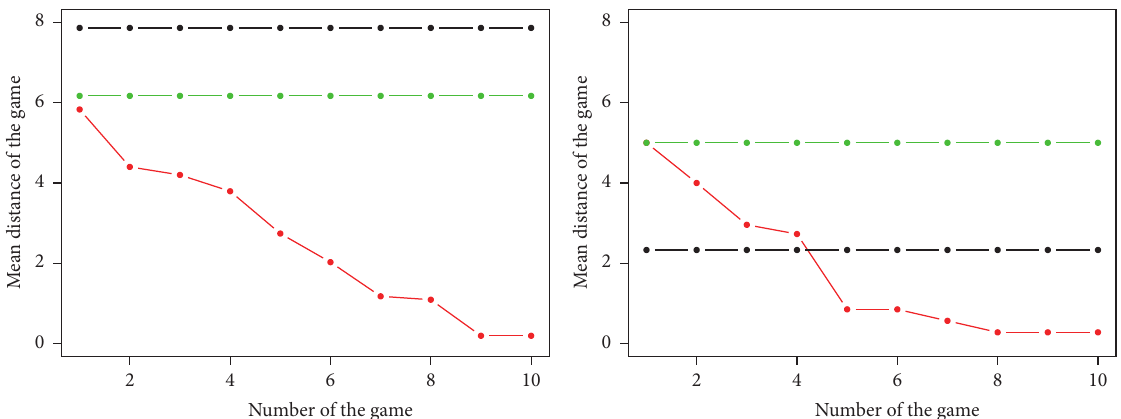
Figure 4: Average distance for each game. Each figure represents a precise path. The green line represents an AI with no machine learning and which used a uniformly distributed transition matrix. The black line represents the same AI but this time one that used a transition matrix built using game experience, as Hladky and Bulitko did. Finally, the red line was obtained by playing against our AI with adaptive memory.